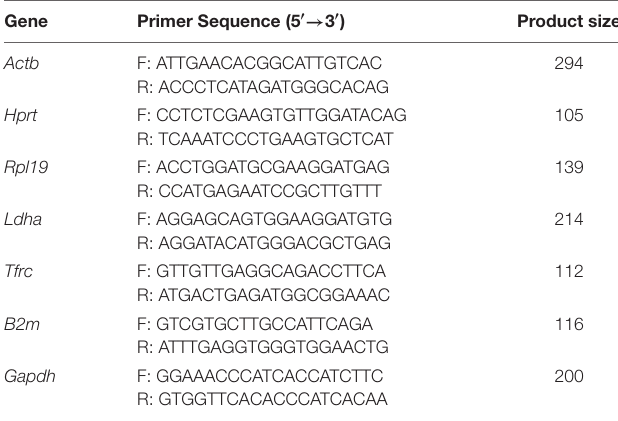
TABLE 5 | Characteristics of MS patients according to clinical